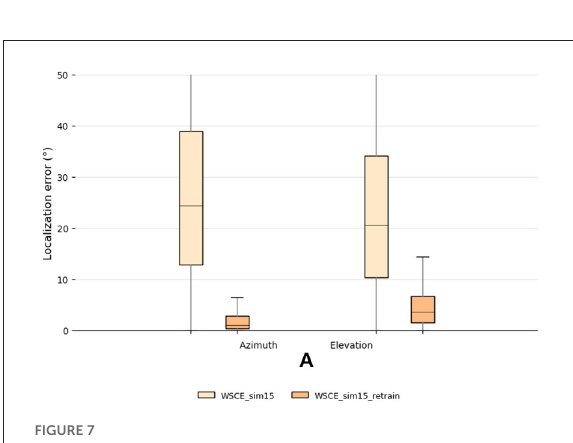
FIGURE7 Testing set localization performance for the WSCE_sim15 and WSCE_sim15 retrained with 33 different HRTFs other than the once used in generating test